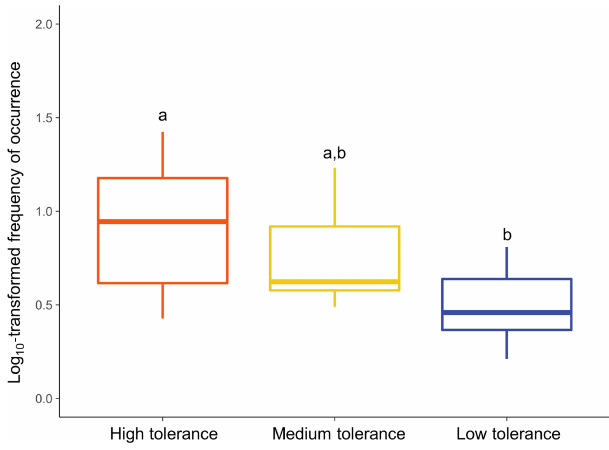
Figure 7. Relationship between frequencies of occurrence and type of patterns followed. Overall frequencies of occurrence were cal- culated for each common taxon at the DO range corresponding to that taxon’s assigned pattern of utilisation. Differential letters above boxes denote statistically different means of frequency of occur- rence among types of patterns of utilisation (Dunn test: p< 0 .